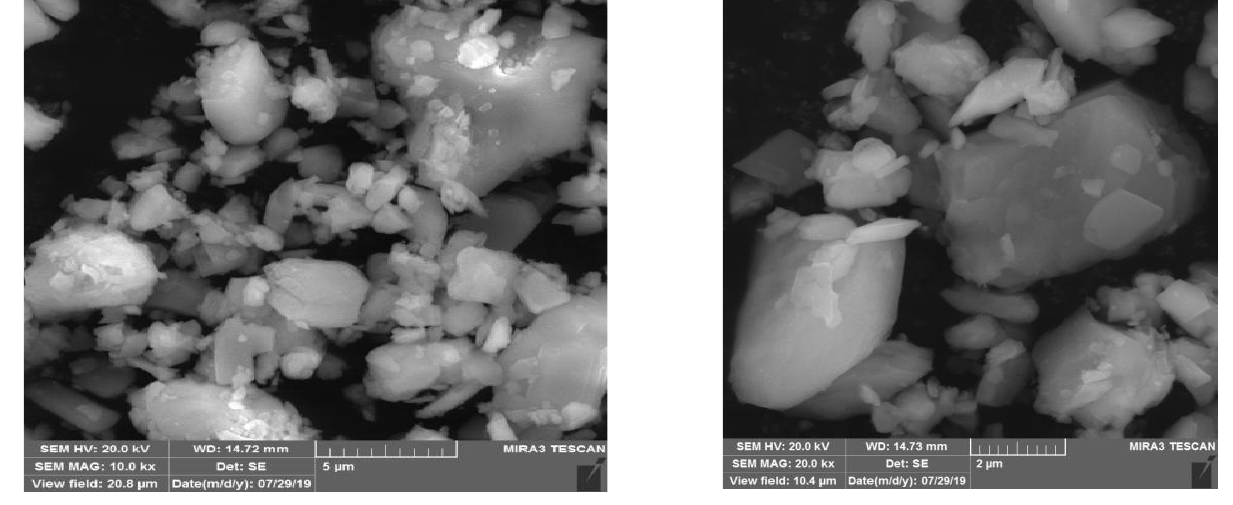
Figure 4. SEM images of RE 2 (C 2 O 4 ) 3 .